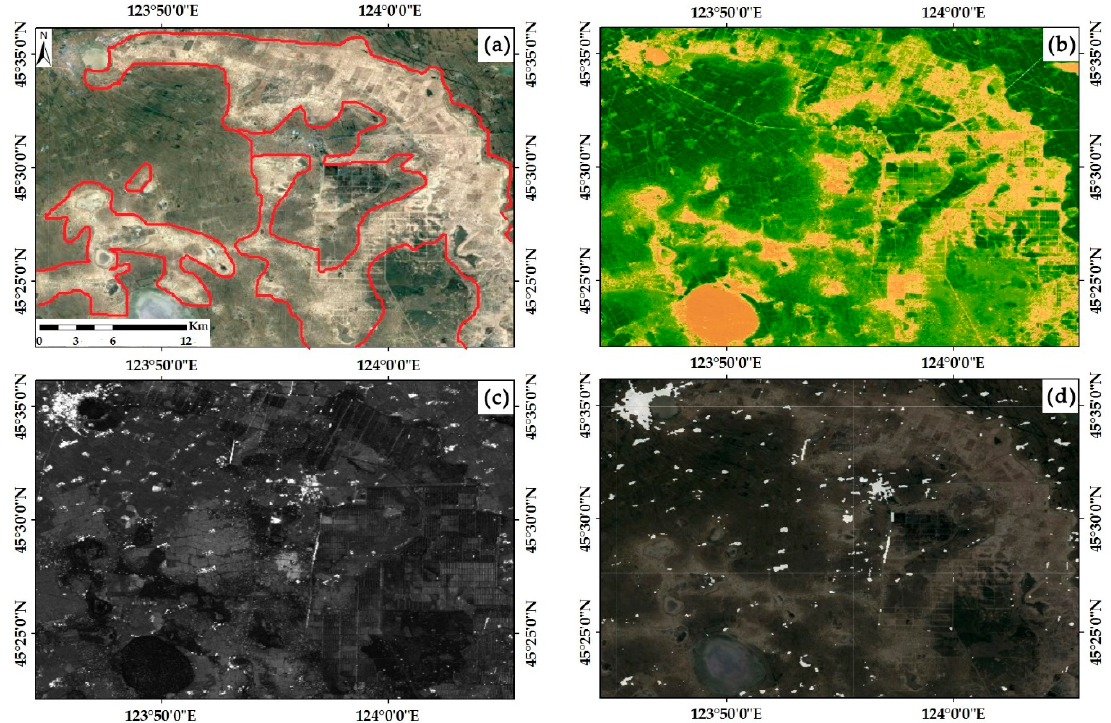
Figure 13. The combined use of optical and SAR data. ( a ) The Google Earth image of test area, the red polygon in ( a ) shows the bare soil; ( b ) The result of NDVI_max; ( c ) the σ ◦ mean of SAR data; ( d ) the FUL result.